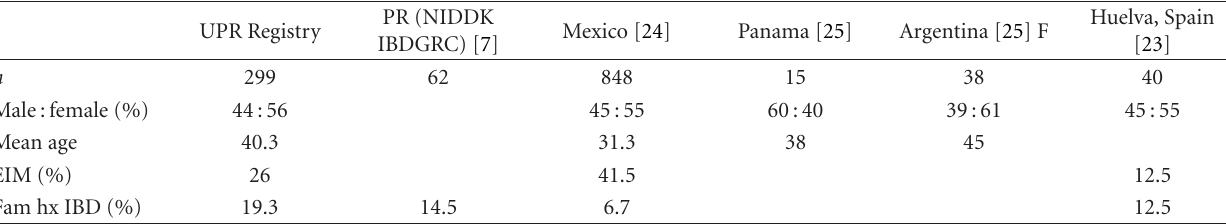
Table 4: UC: comparison with other Hispanic